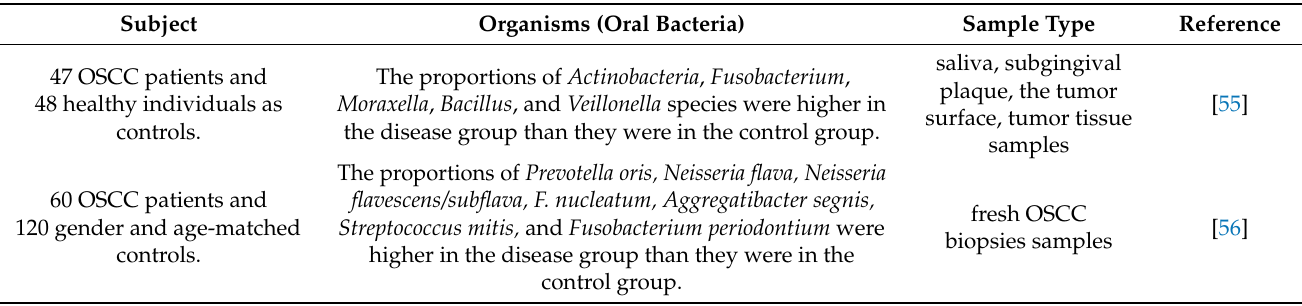
Table 1. Oral organisms associated with oral